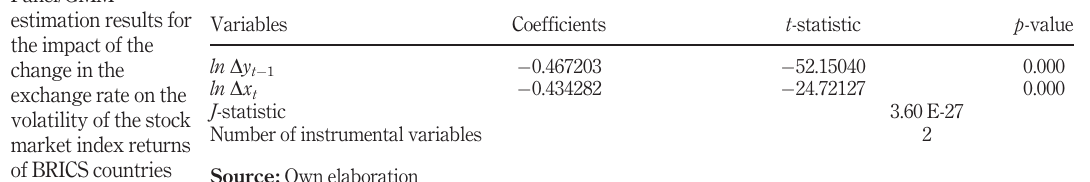
estimation results for the impact of the change in the